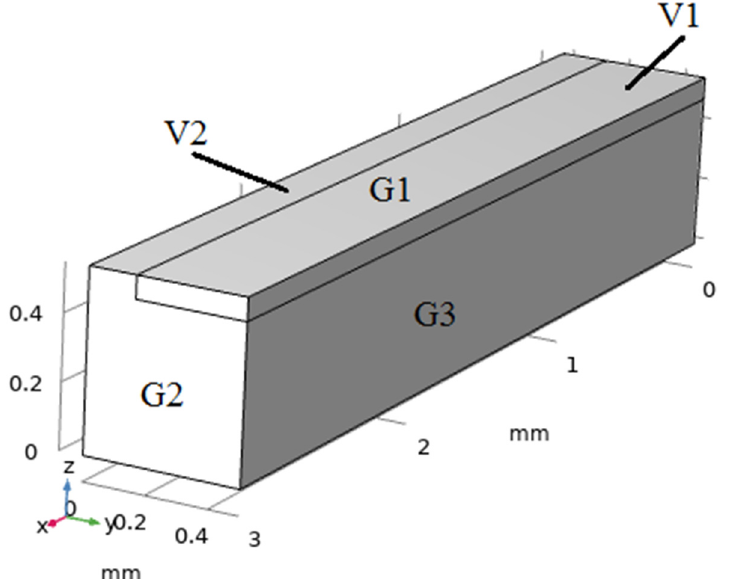
Figure 6. Computational domain used for numerical simulation.